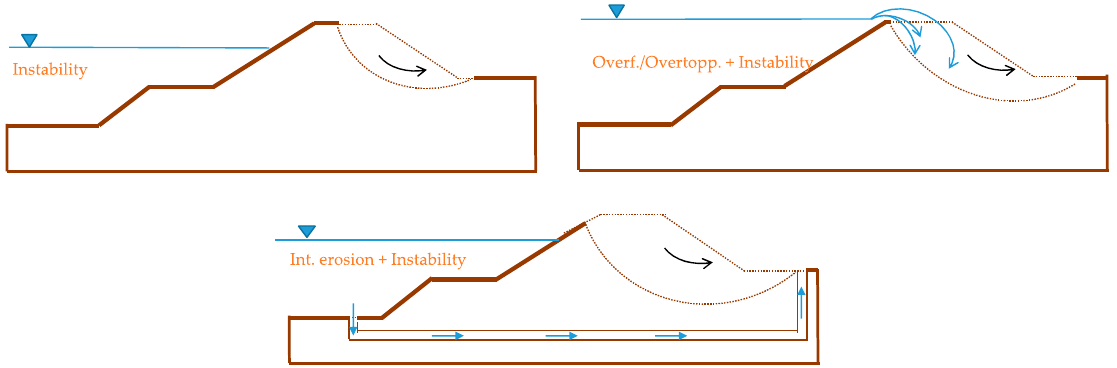
Figure 13. A schematization of an instability failure with three possible initiation mechanisms.